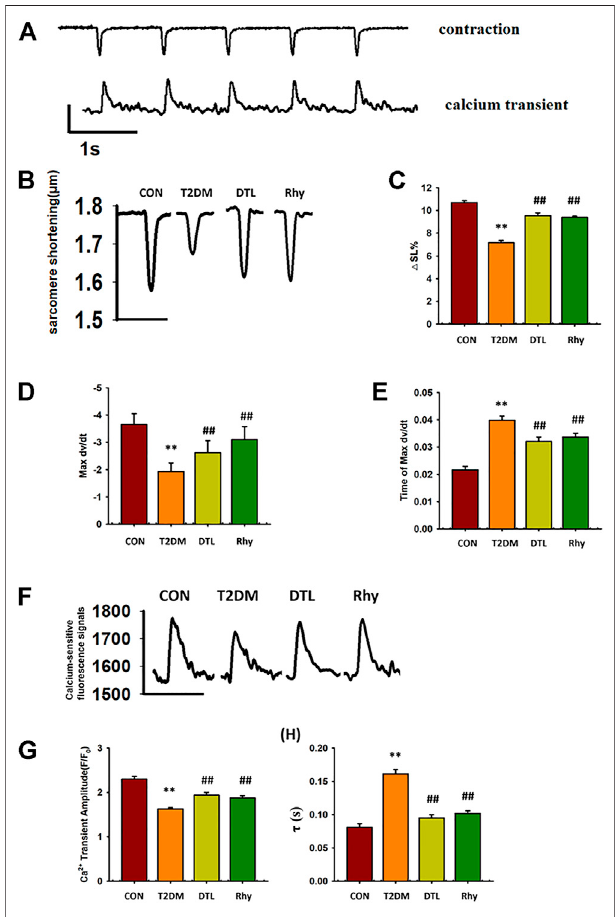
FIGURE 7 | Effect of rhynchophylline on cardiomyocyte contraction and calcium transient. (A) Representative real-time monitoring of ventricular myocyte contraction and calcium transience images. (B) Representative monitoring of ventricular myocyte contraction in each group. (C) The amplitude of cardiomyocyte contraction. (D) The maximum rate of cell contraction. (E) The time for cells to reach the maximum rate of contraction. (F) Representative monitoring of ventricular myocyte calcium transience in each group. (G) The magnitude of calcium transience ( △ F/F 0 ). (H) The tau value( τ ) ofcalcium transience. Values are presented as mean ± standard error of the mean. ** p < 0.01 vs. control group; # p < 0.05, ## p < 0.01 vs. type 2 diabetes mellitus group. Abbreviations: N, mouse; n, cell. n = 3 each group, n ≥ 10 each group, 1-way analysis of variance, Holm – Sidak post-hoc test.